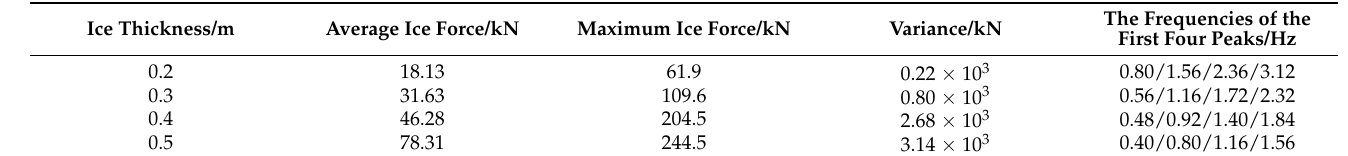
Table 7. Statistics of ice force under different Ice thickness (hi).